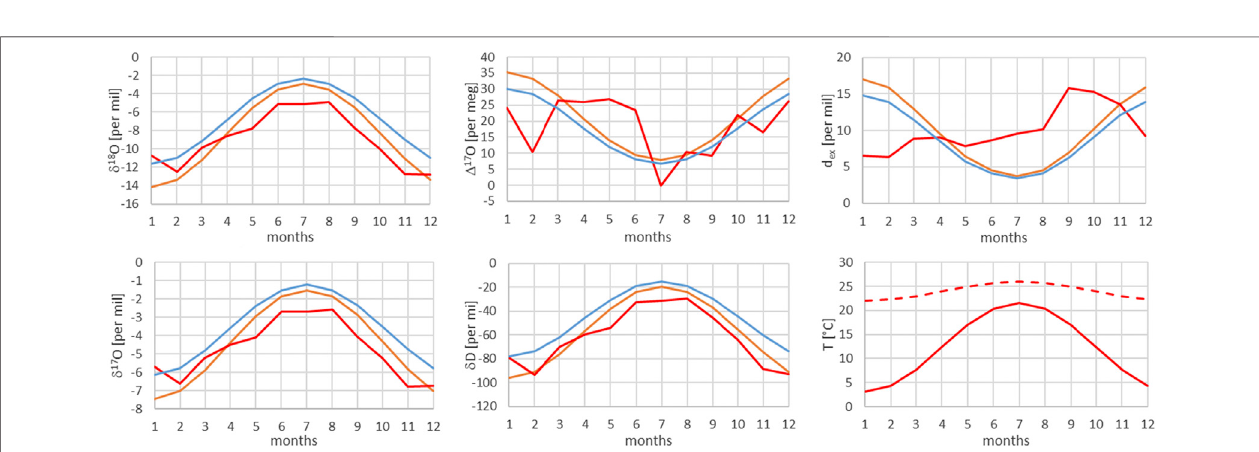
FIGURE 8 | Comparison of monthly mean measured (red) and modeled (for the isobaric case (orange) and for the dry adiabatic case (blue)) isotope ratios for Locarno. The dashed red line corresponds to the assumed source temperature.